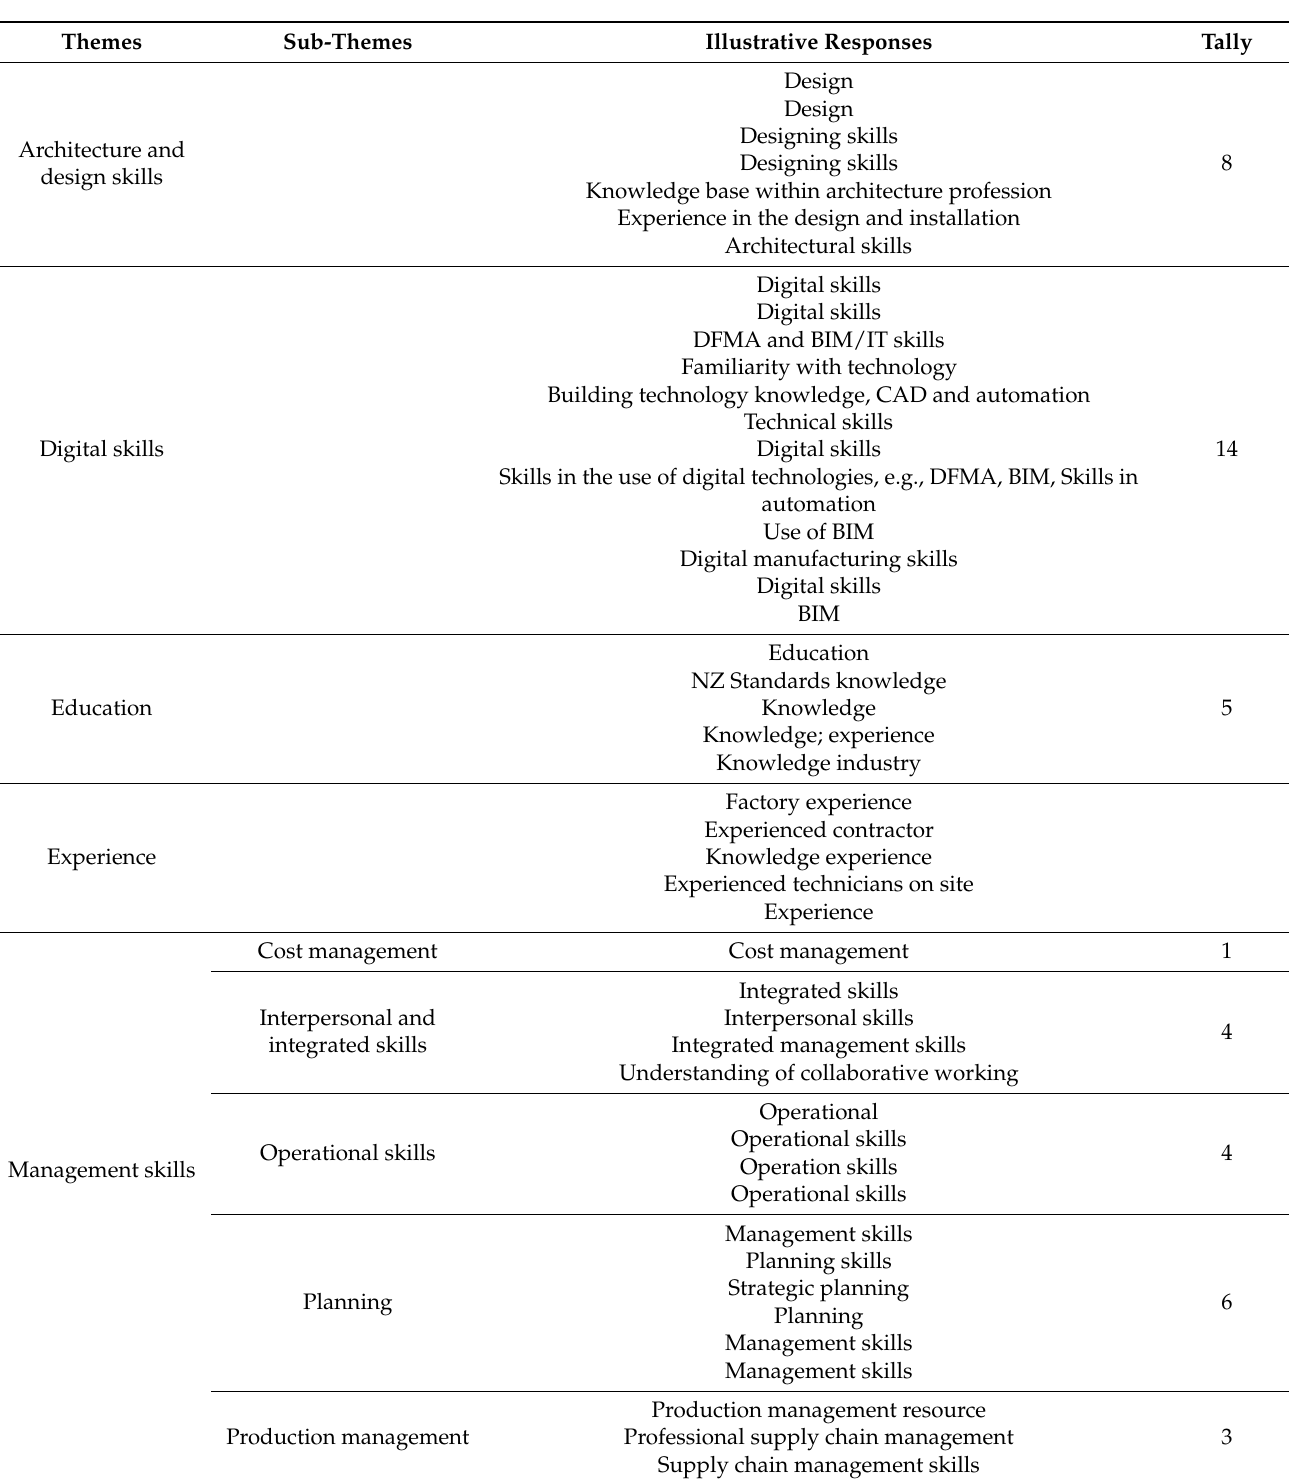
Table 5. Critical skills essential to improving the